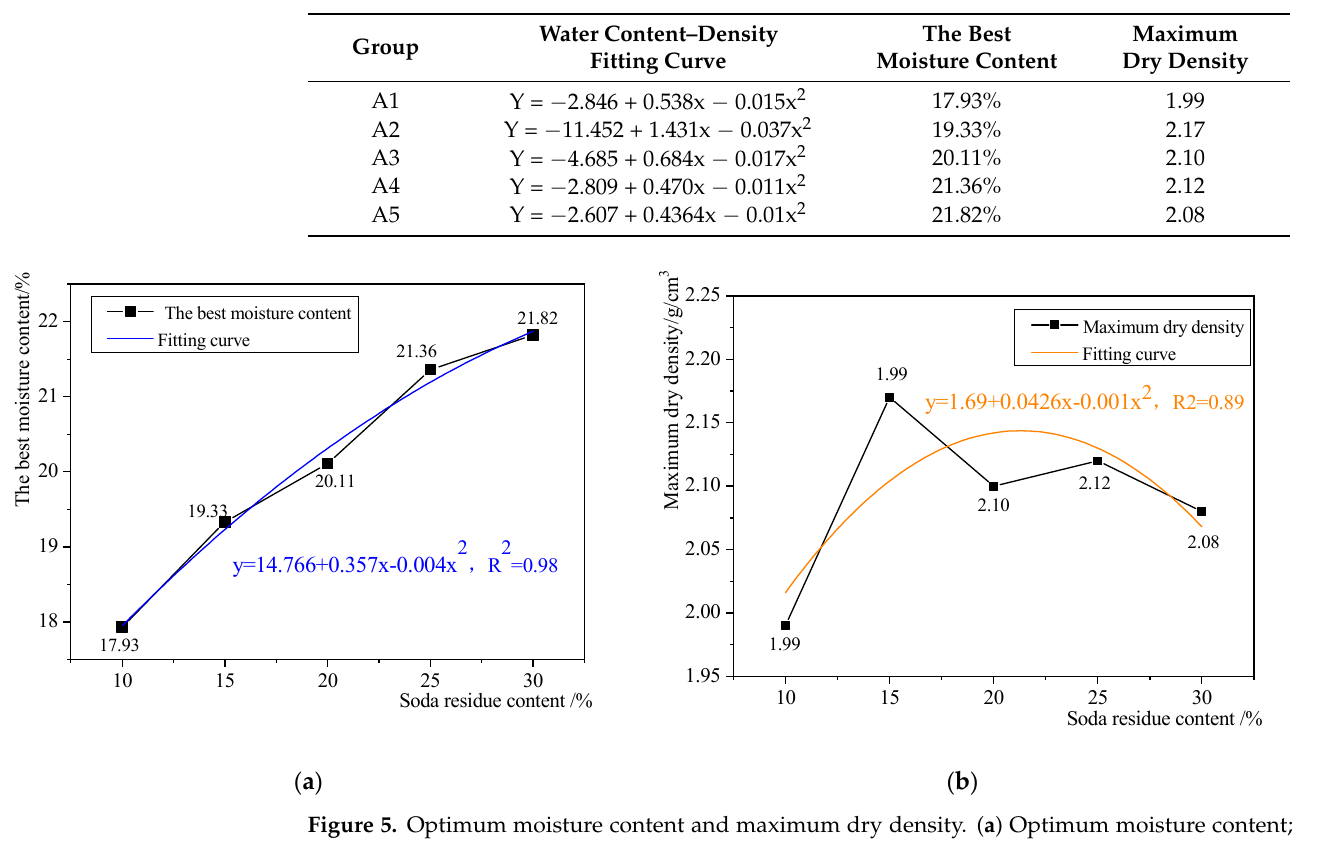
Figure 5. Optimum moisture content and maximum dry density. ( a ) Optimum moisture content; ( b ) Maximum dry density.